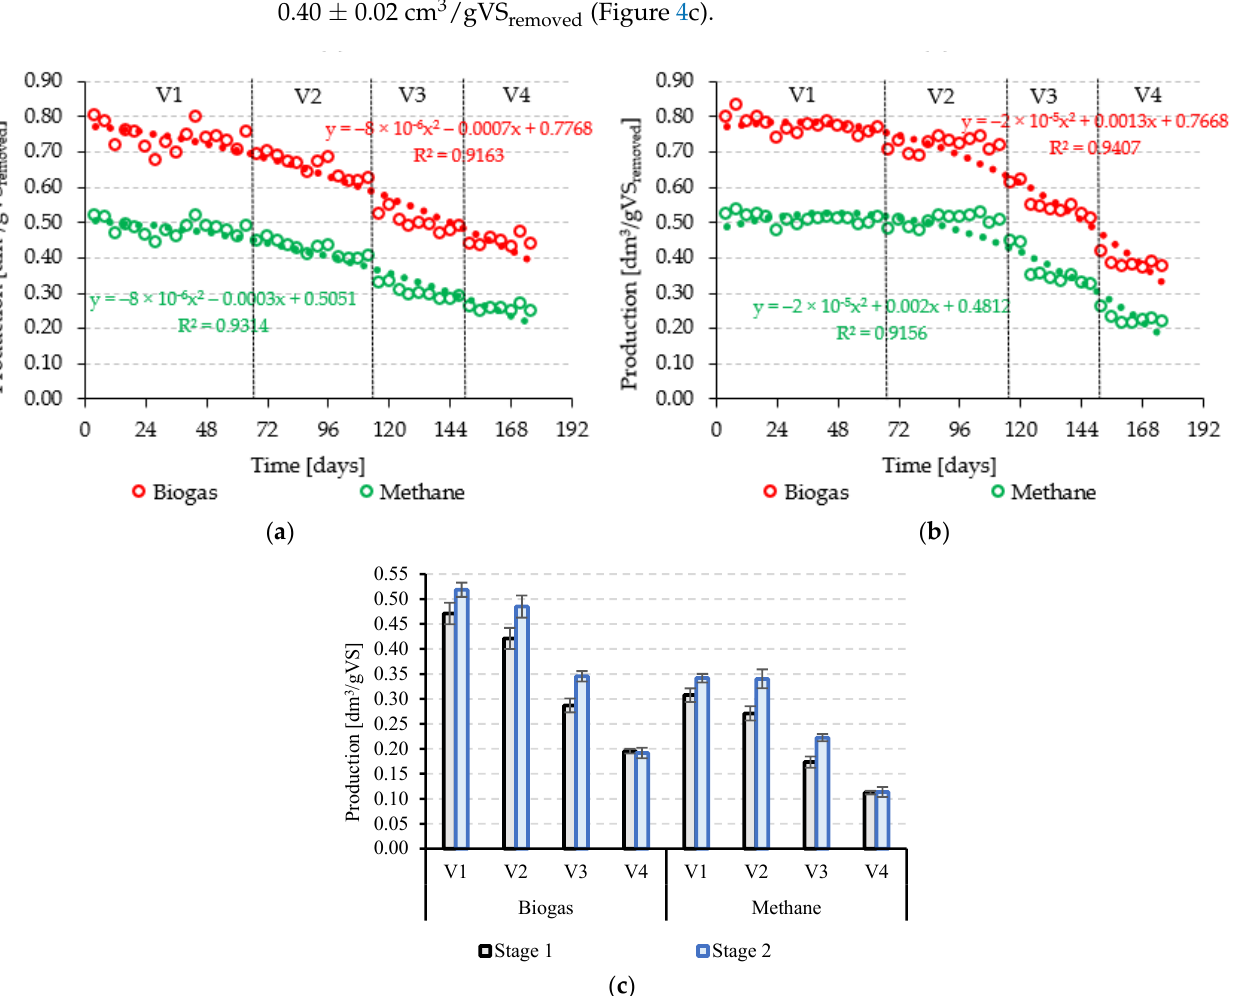
Figure 4. Biogas and CH 4 production in relation to VS removed in S1 ( a ) and S2 ( b ), with mean values in relation to VS added ( c ).